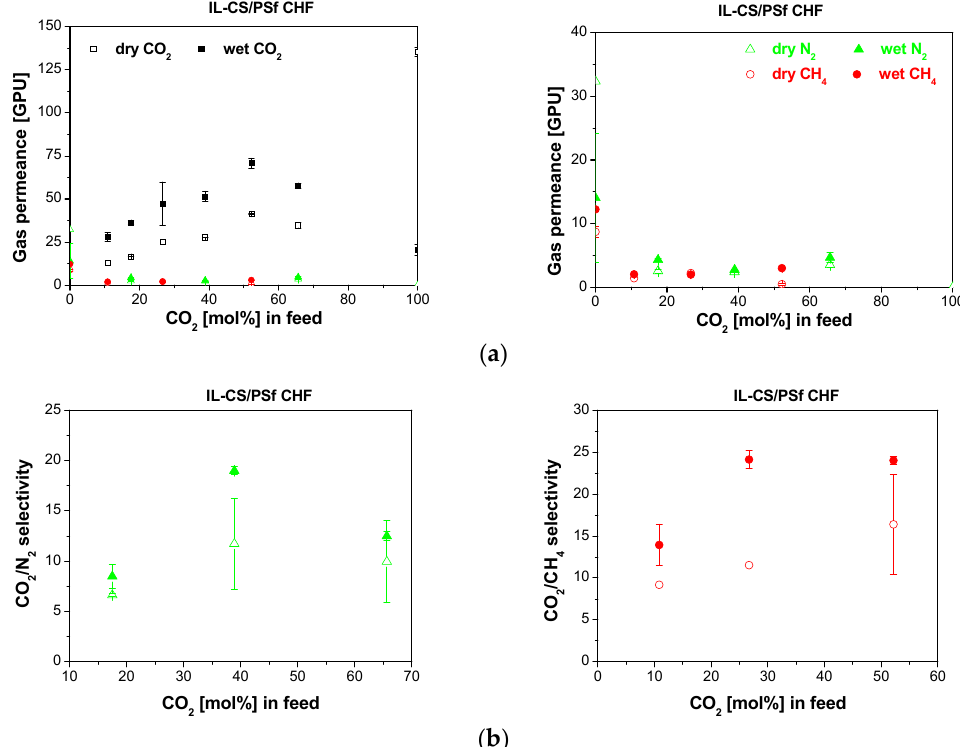
Figure 5. Gas permeance ( a ) and selectivity ( b ) obtained for the separation of CO 2 /N 2 (left) and CO 2 /CH 4 (right) mixtures through the IL ‐ CS/PSf CHF membrane in dry (void symbols) and wet (full symbols). The right side of figure ( a ) shows the trend in the slow gas (N 2 , CH 4 ) permeance.